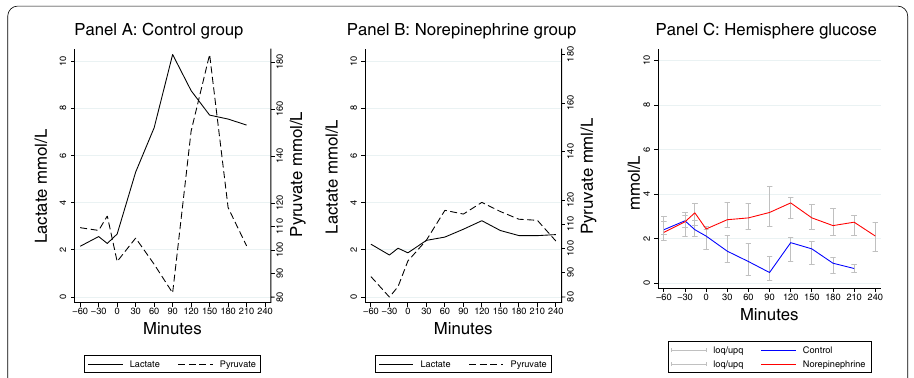
Fig. 3 Median (interquartile range) values of lactate, pyruvate and glucose concentrations in the hemisphere in the controls and NE group during the experiment. Note that the increase in LP ratio in the control group during hypoperfusion is due to an increase in lactate simultaneously with a decrease in pyruvate. After resuscitation the lactate levels in the control group remains elevated but he pyruvate levels trends towards normalising. In addition, note the normalisation of glucose in the control group after resuscitation. Control n 4. NE group n 8; loq lower quartile, upq upper = =